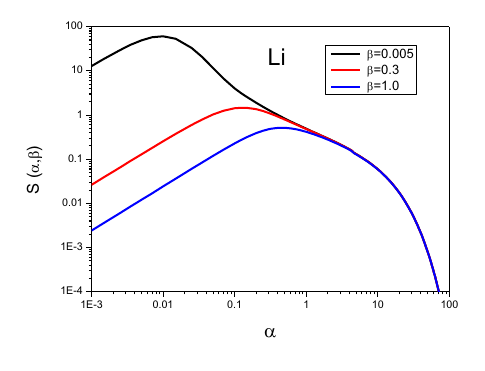
Fig. 7. at different 𝑆𝑆(𝛼𝛼, 𝛽𝛽)